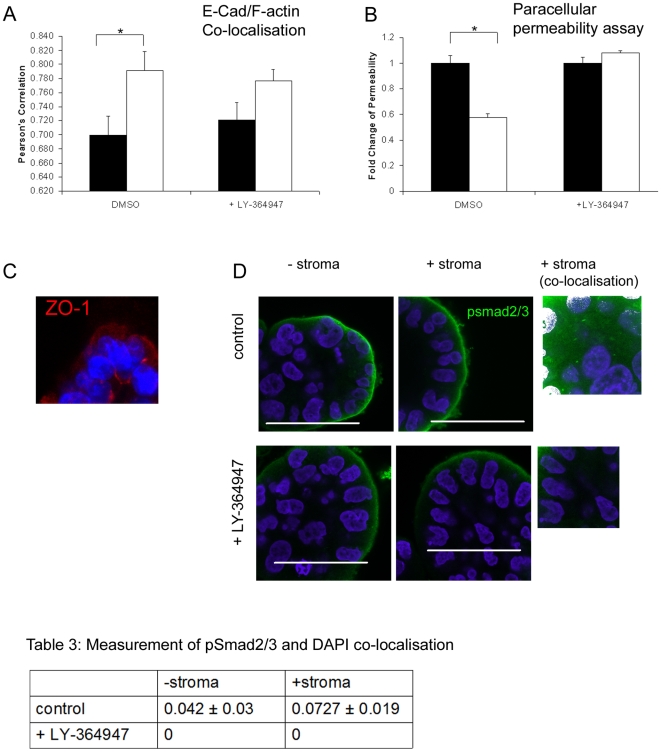
Inhibition of TGFβ signalling disrupts E-cadherin and F-actin co-localisation and cell to cell adhesion.3D BPH-1 acini were cultured for 7 days in the presence (white bars) or absence of stroma (black bars). Both conditions were treated with 500 nM LY-364947 or DMSO for 7 days. (A). E-cadherin and F-actin co-localisation (n = 10) was measured and the Pearson's correlation plotted *p<0.05. (B). A paracellular permeability assay measured the ability of 70 kDa dextran to diffuse into the lumen of 3D acini. Six wells were measured per assay and the results are representative of two experiments cultured with 2 different stroma. (C). Mid-section of BPH-1 3D acini immunostained for ZO-1 (red), DAPI (blue). Intense staining can be seen at the luminal and lateral membranes. (D) Confocal images of the expression of pSmad 2/3 after 7 days growth. Nuclear staining was not visible without refocusing and recalibrating the confocal microscope away from the basal membrane (+stroma co-localization). Nuclear co-localisation (white) of pSmad 2/3 (green) and DAPI (blue) was only found in the absence of LY-364947. Table 3. Co-localisation was measured (as above) and calculated using Volocity software to obtain the Pearson's correlation (n = 4). All nuclear images were taken at equivalent settings to compare green and blue co-localisation.